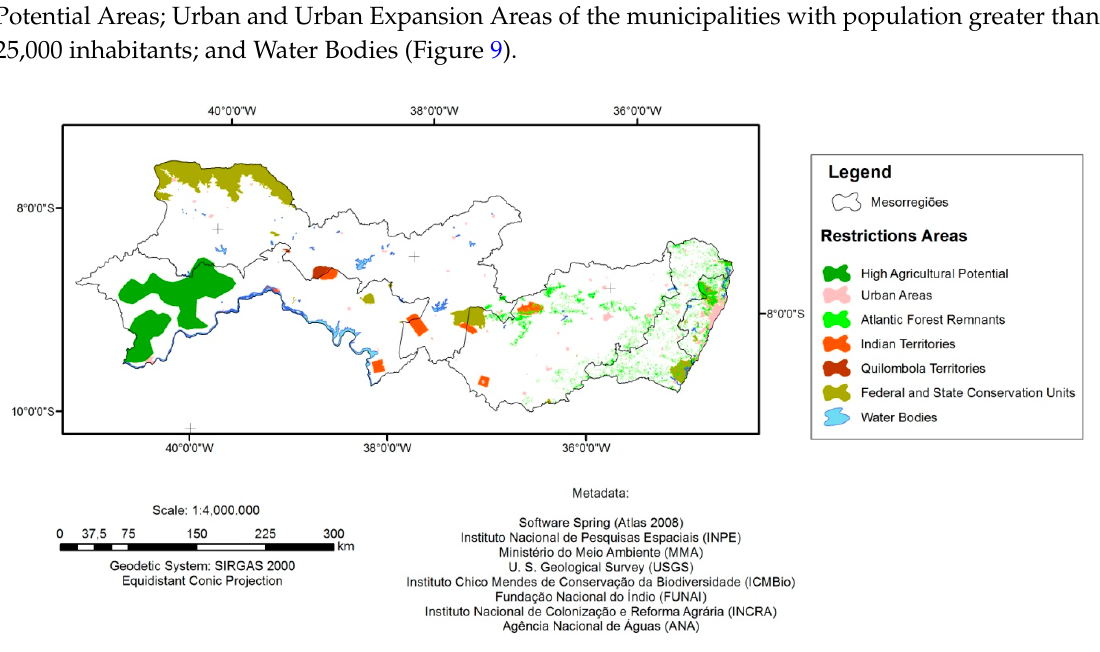
Figure 9. Map of the Restriction Areas of the State of Pernambuco.